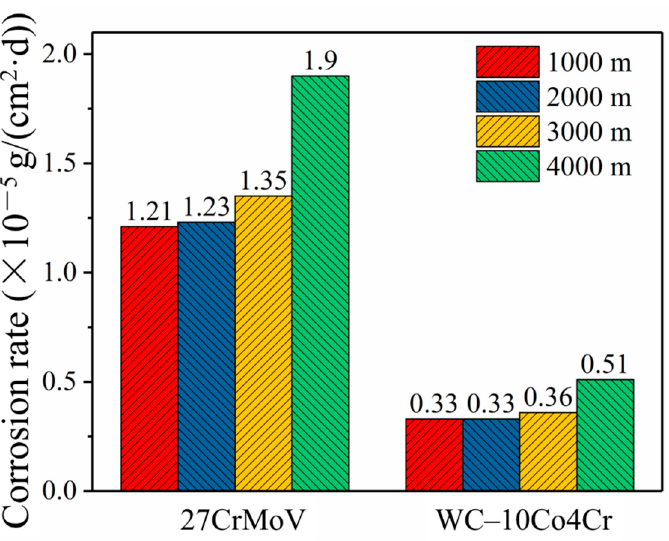
Figure 4. Comparison of the corrosion rates of 27CrMoV substrate and WC–10Co4Cr coatings at different drilling depths obtained by simulation.